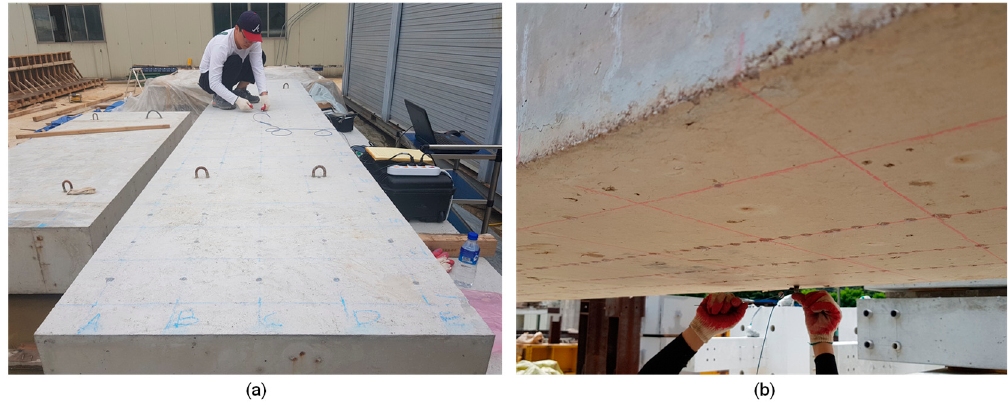
Figure 7. Pictures of IE testing on the test-specimens: ( a ) solid concrete and ( b ) fire-damaged concrete.